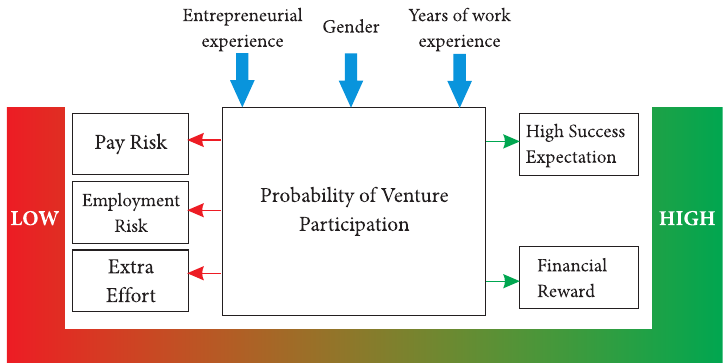
Fig. 1. Proposed attributes influencing employee participation in CE